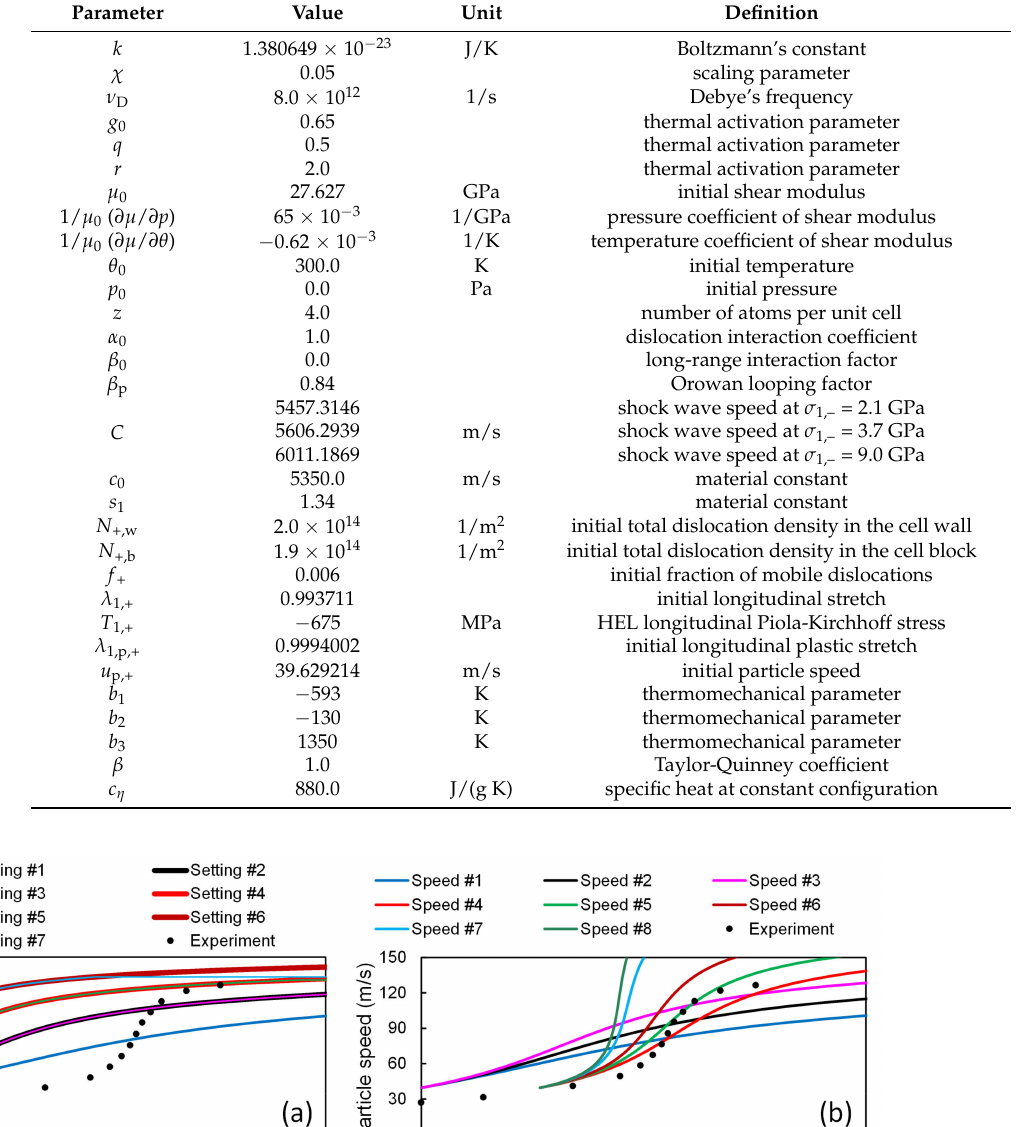
Table 4. Material and operating parameters in Equations (71)–(86) and their values for 6061-T6 Al alloy at ambient conditions (taken from [2,4] unless described otherwise).